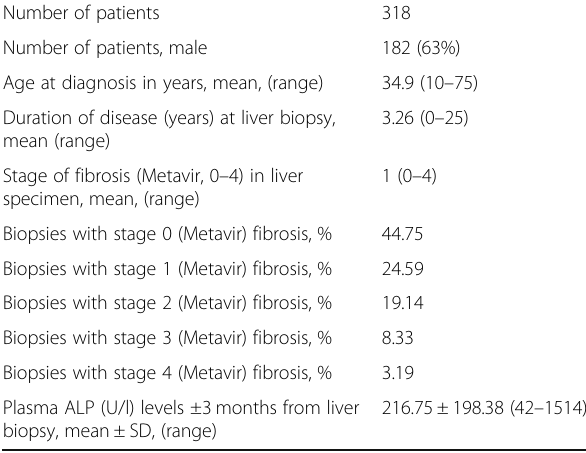
Table 1 Primary sclerosing cholangitis (PSC) patient cohort